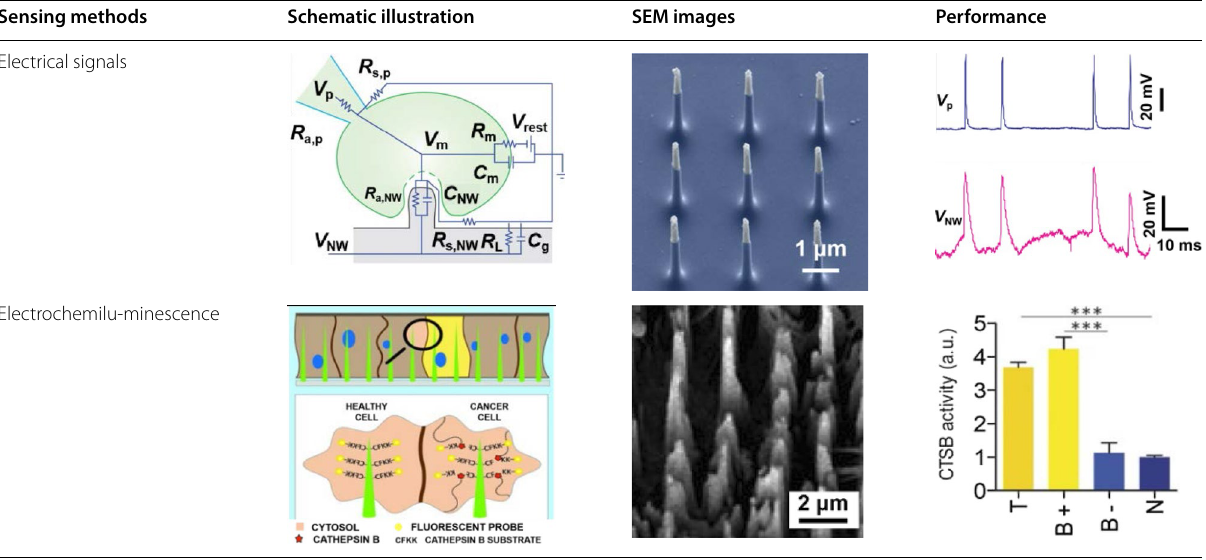
Table 3 Cell sensing applications of nanoneedles Sensing methods Schematic